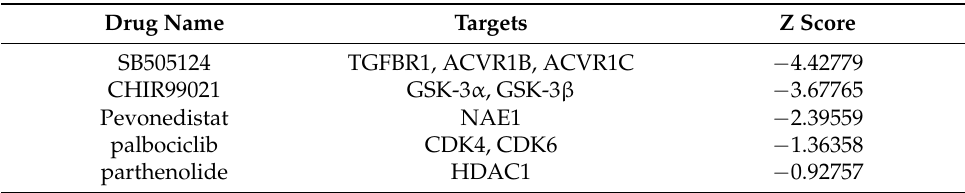
Table 1. Selection of the 5 drugs for which VA-ES-BJ cell line was